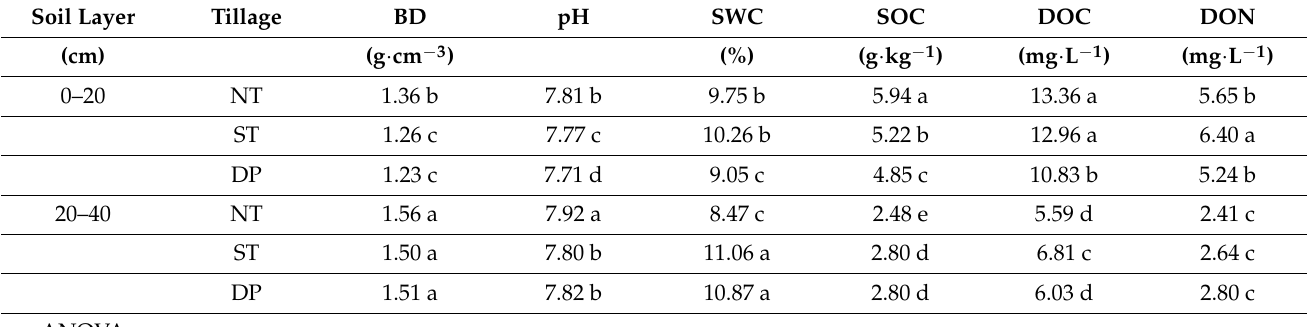
Table 3. Effects of tillage methods on soil physical and chemical properties in the 0–40 cm soil